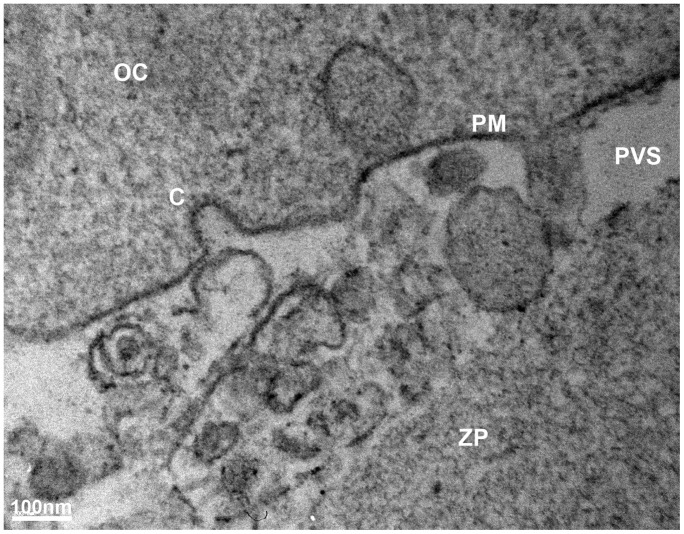
Electron micrographs of caveolae-like microdomains in the mouse oocyte.Ultrastructural plasma membrane with a caveolae-like invagination. OC: Oocyte Cytoplasm; PM: Plasma Membrane; PVS: PeriVitelline Space; C: Caveola; ZP: Zona Pellucida.